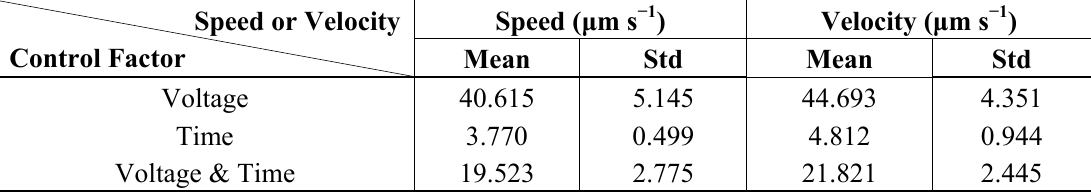
Table 7. Relationship between the different control factors and the speed or